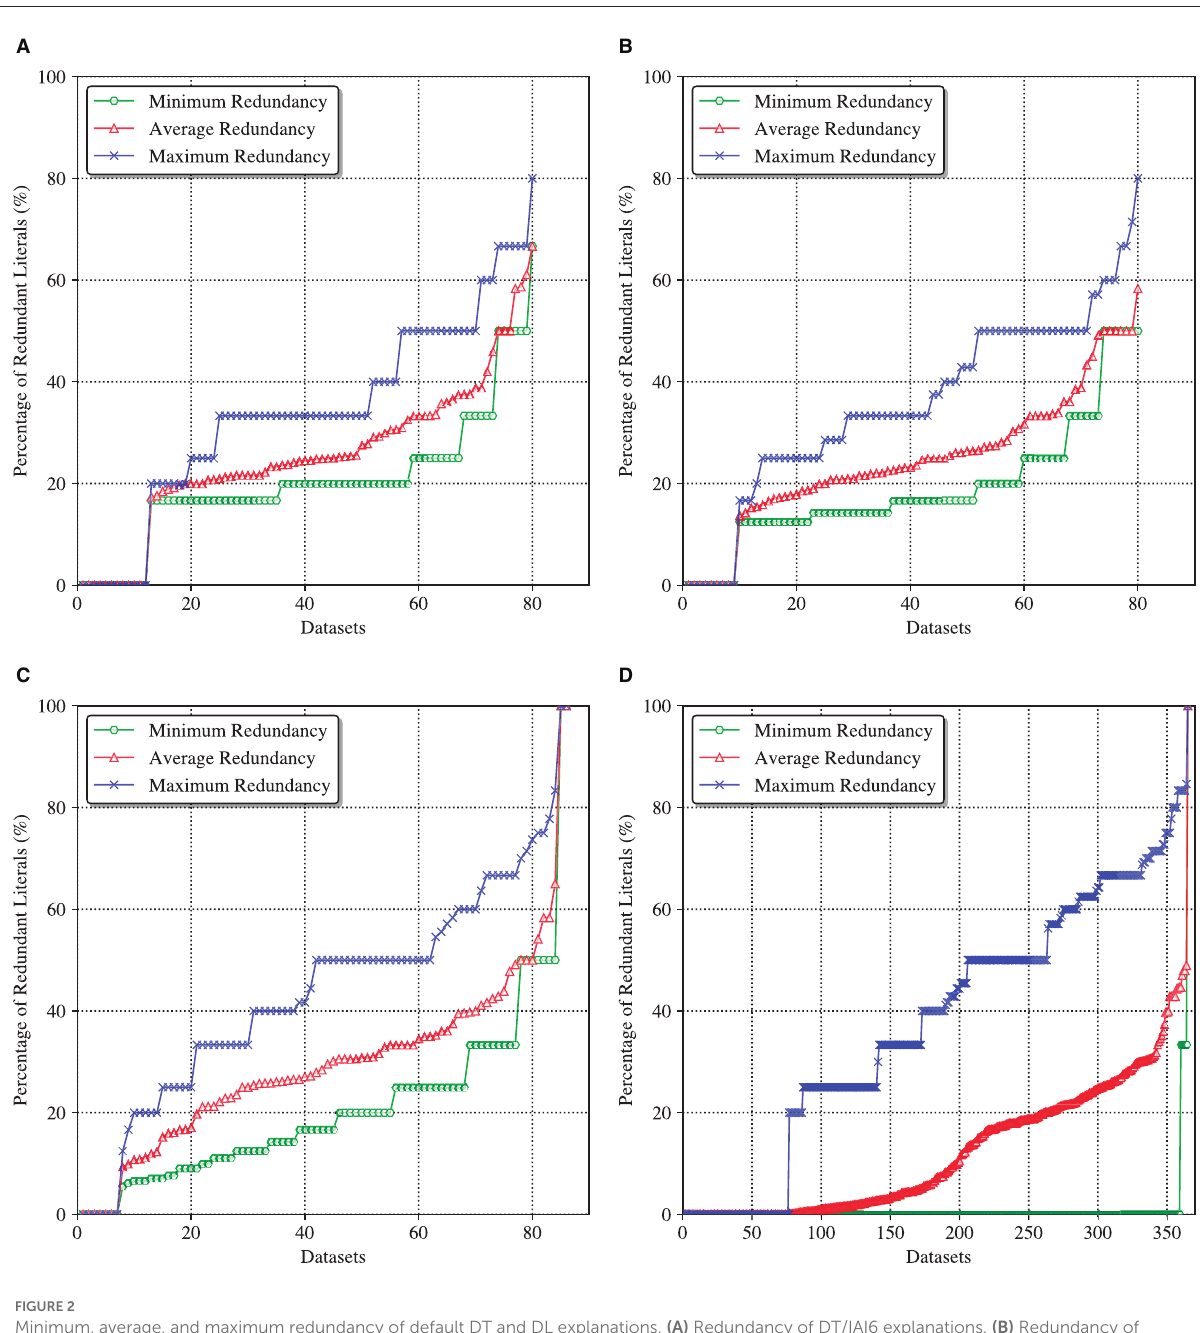
FrontiersinArtificialIntelligence